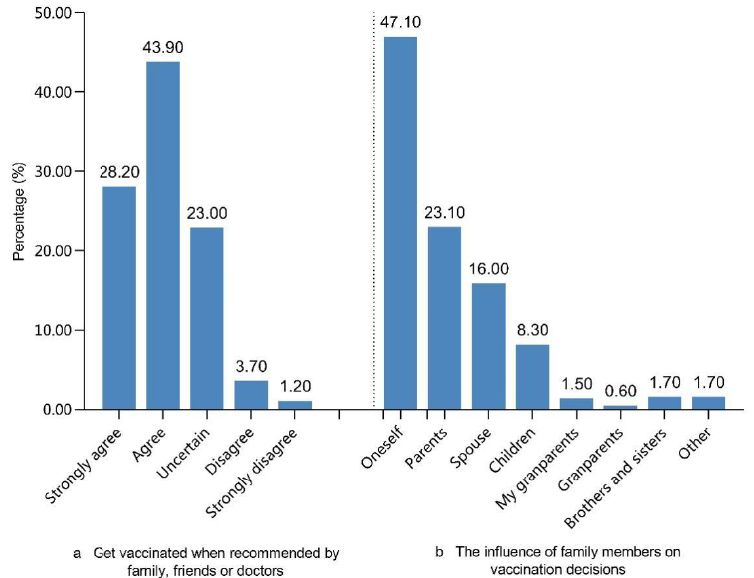
Figure 1. Impact of peer groups on vaccination attitudes. ( a ) Attitudes towards non-EPI vaccinations recommended by family, friends, or doctors. ( b ) Impact of family members on non-EPI vaccination decisions (N = 7318).